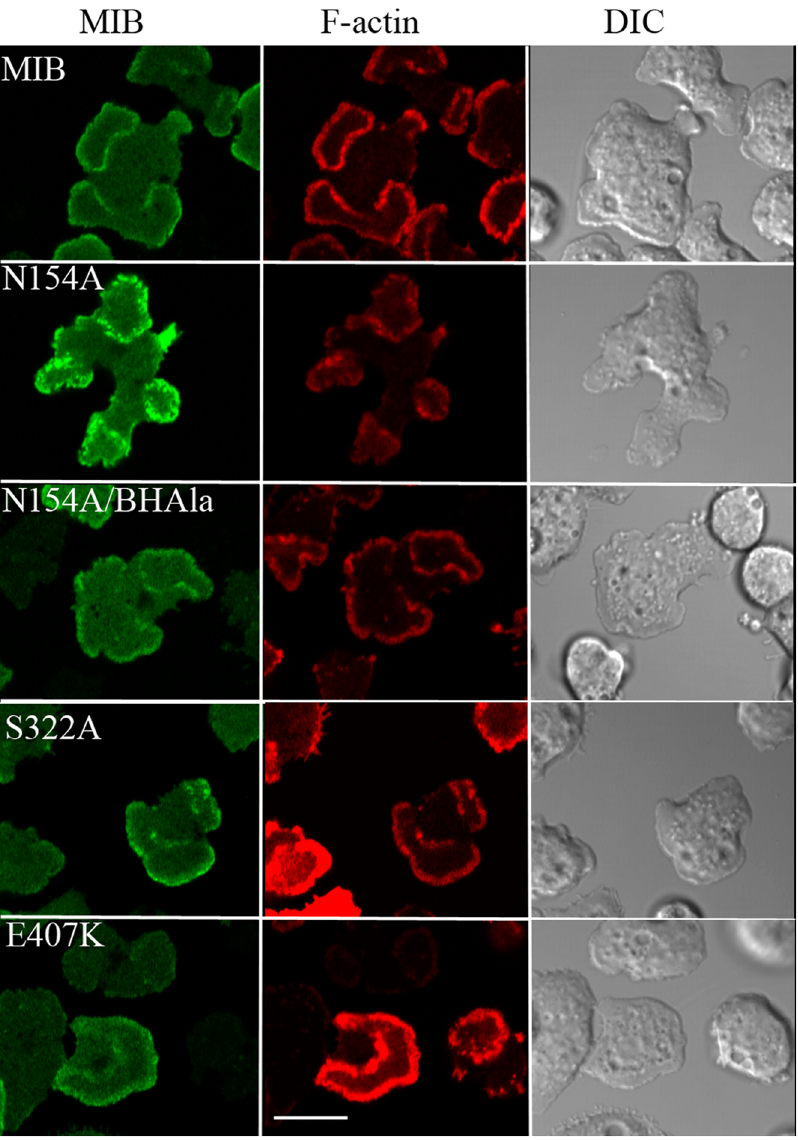
Figure 9. Actin binding through the head contributes to MIB association with waves. myoB 2 -cells were co-transfected with mRFP-lifeact and either GFP-MIB or GFP-tagged N154A, N154A/BH-Ala, E407K or S322A, as indicated in the figure. Cells were starved for 30 min after which 1 m M latrunculin was added and cell images were recorded. Bar is 10 m m.